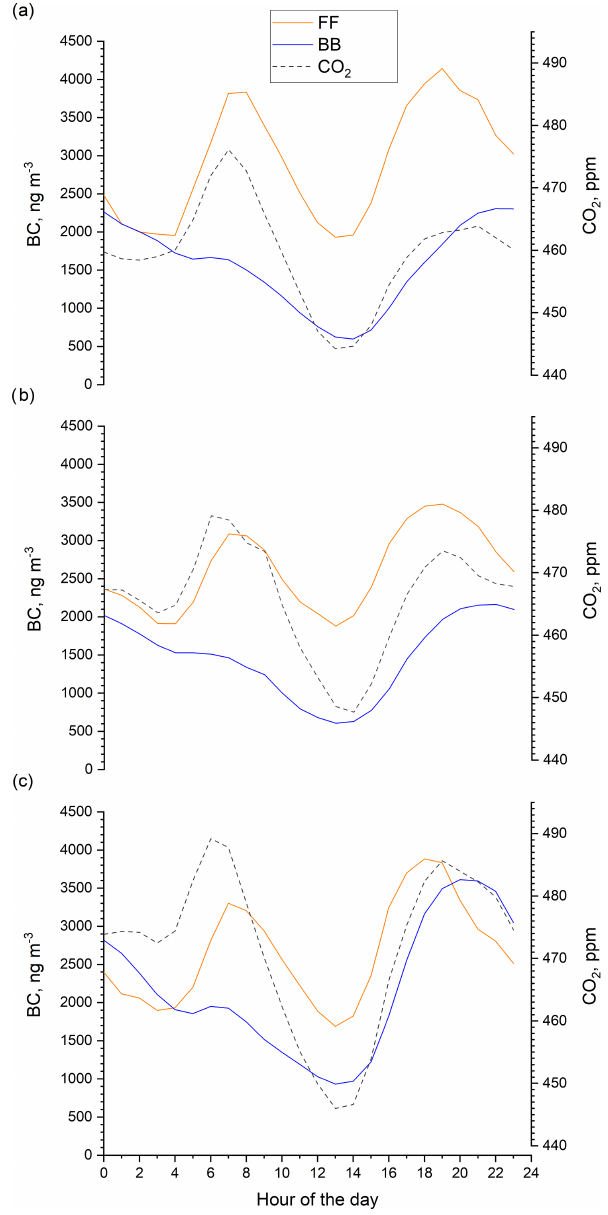
Figure 4. Diurnal variation of the FF- and BB-related BC compo- nents as well as the CO 2 concentration at the (a) BTC, (b) SKY, and (c) TRO monitoring locations. The timescale represents local